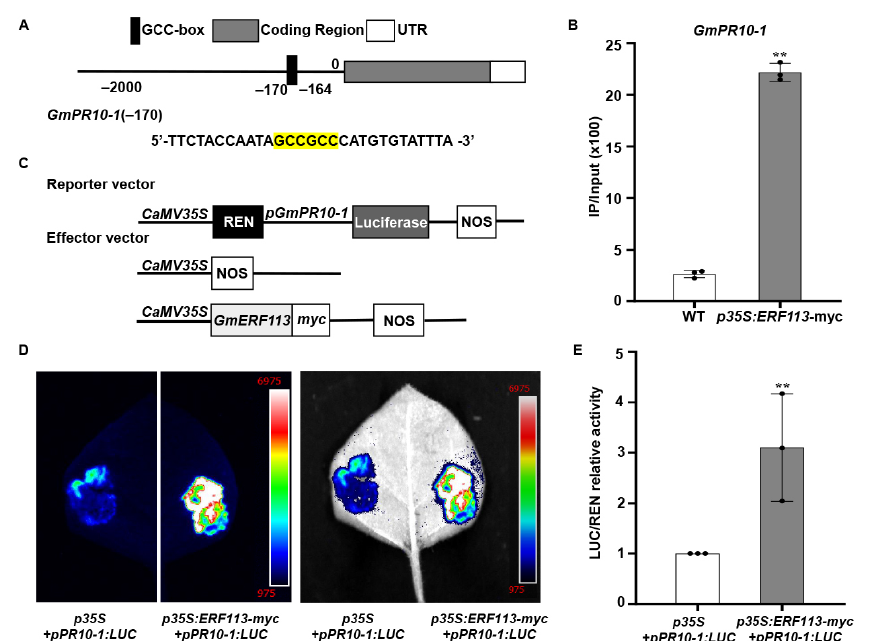
Figure 4. GmPR10-1 was identified as a target of GmERF113. ( A , B ) ChIP analysis of GmERF113 binding to the promoter region of GmPR10-1 . Chromatin from transgenic soybean plants expressing GmERF113-myc or the WT were immunoprecipitated with or without the anti-myc antibody. The precipitated chromatin fragments were analyzed with qPCR using a pair of specific ChIP-qPCR primers, which amplifies the GCC-box (highlighted in yellow) upstream of GmPR10-1 , as indicated. One-tenth of the input (without antibody precipitation) of chromatin was analyzed and used as a control. A total of three biological replicates, each with three technical replicates, were averaged and statistically analyzed using Student’s t -test ( ** P < 0.01). The bars indicate the standard deviation of the mean. ( C ) Schematic representation of the reporter and effector constructs that were used in the dual luciferase assays. ( D ) The dual luciferase assays in tobacco leaves showing that GmERF113 activates the expression of GmPR10-1 by combining the GmPR10-1 promoter. Representative pictures were taken. ( E ) LUC/REN activity detection to verify GmERF113 activates the expression of